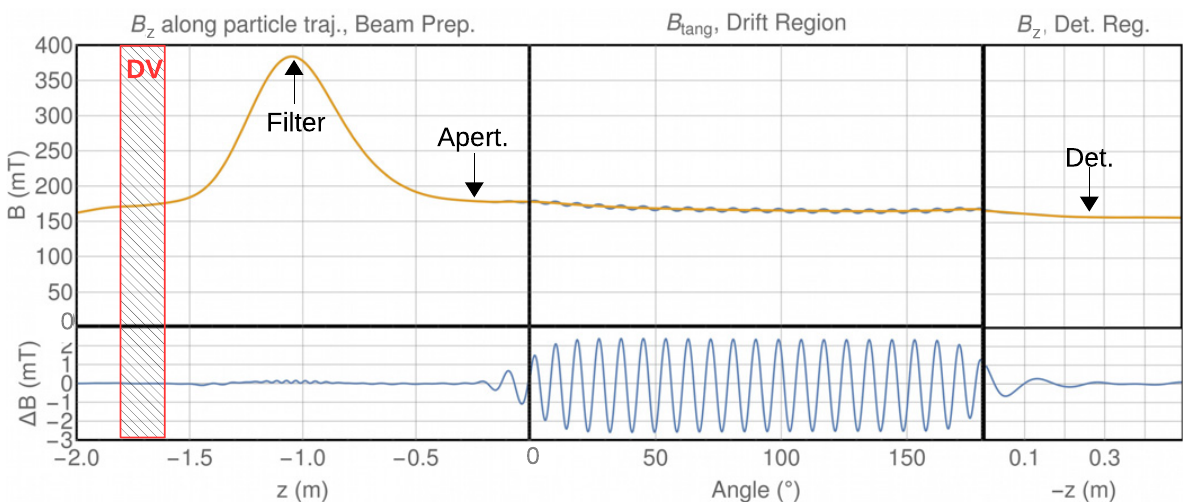
Figure 3. Top: Shape of the magnetic field for the preliminary design of the NoMoS magnet system. Shown are the decay volume (DV – indicated with shading), beam preparation area, drift and detection regions (from left to right). Main component ( B z or tangential B tang ) along an examplary trajectory. Bottom: The residuals represent the difference (cid:1) B of the magnetic field at the particle’s guiding center and its real position. The oscillation in the drift region stems from the radial gradient ∂ B φ /∂ R (for details see Sect. 3).